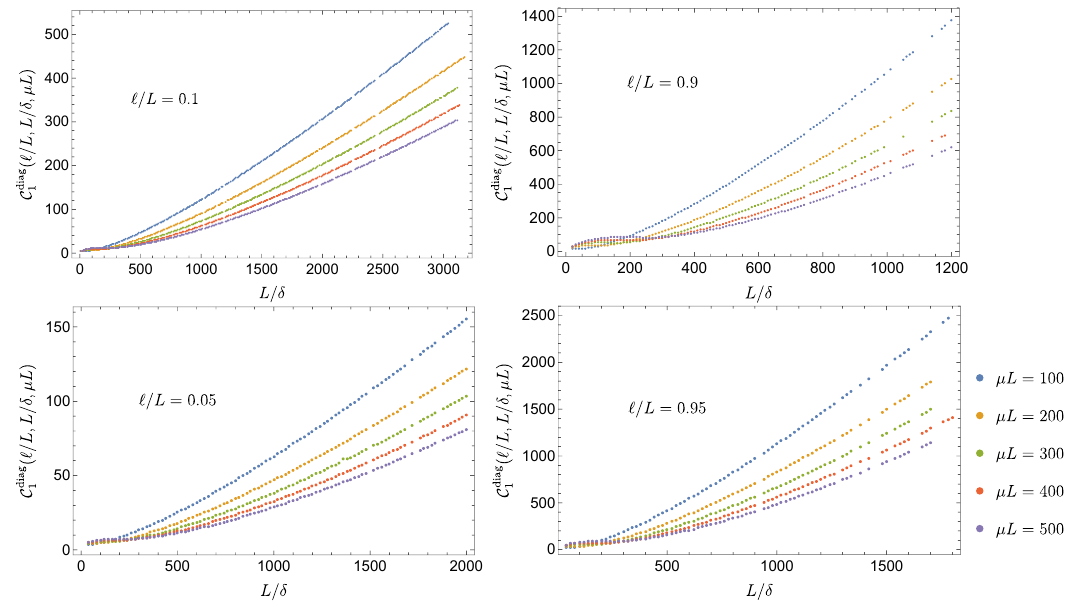
Figure 16 . Puri(cid:12)cation complexity in the diagonal basis for subregions of the vacuum as a function of the lattice cuto(cid:11). The mass was set to mL = 0 : 01. The di(cid:11)erent plots correspond to di(cid:11)erent subregion sizes ‘=L = 0 : 05 ; 0 : 1 ; 0 : 9 and 0 : 95 as indicated and each plot contains (cid:12)ve di(cid:11)erent reference frequencies of (cid:22)L = 100 ; 200 ; 300 ; 400 and 500 respectively. Structure of divergences in puri(cid:12)cation complexity. For subregions with (cid:12)xed